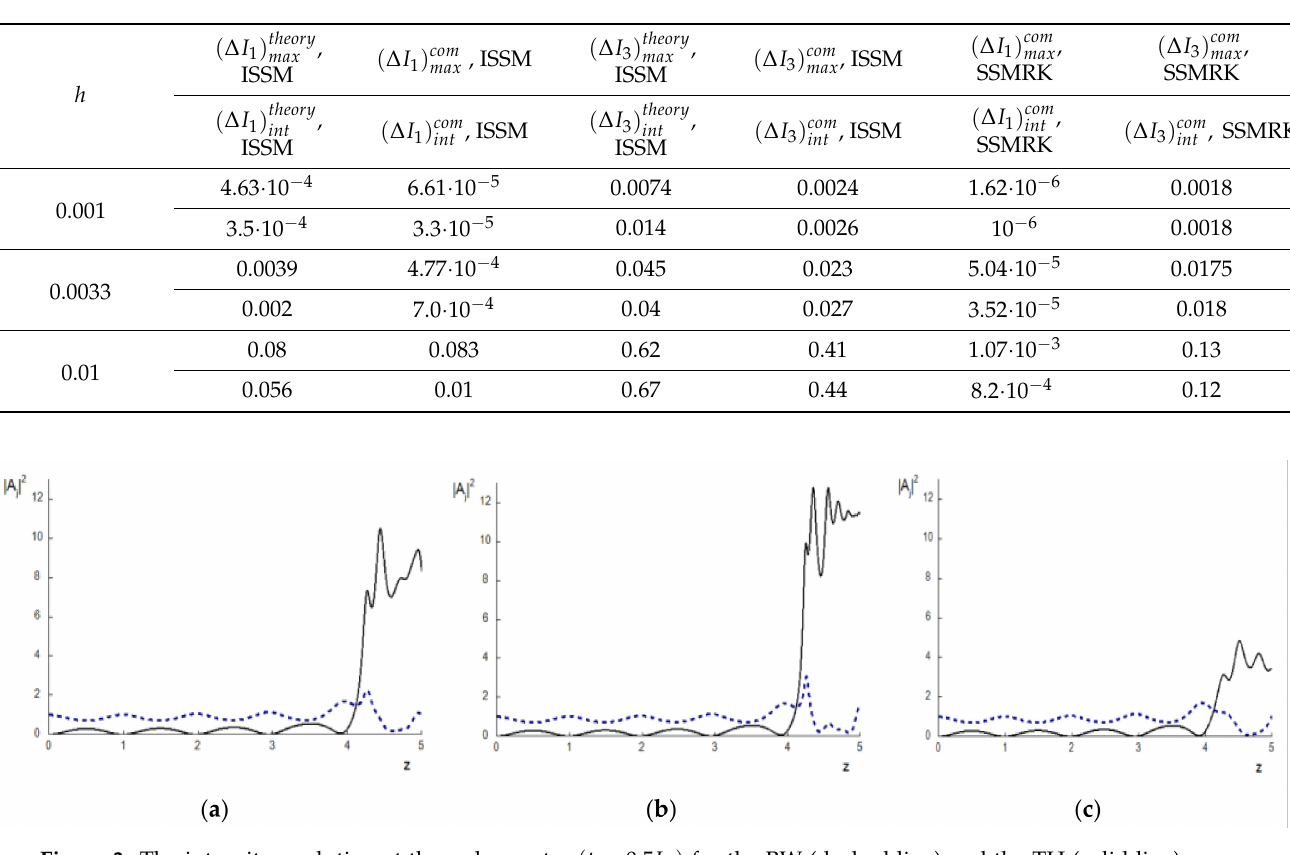
Figure 3. The intensity evolution at the pulse center ( t = 0.5 L t ) for the BW (dashed line) and the TH (solid line) wave computed using the SSMI with mesh steps h = 0.001 and τ = 0.002 ( a ) , 0.0066 ( b ) , and 0.02 ( c ) ,